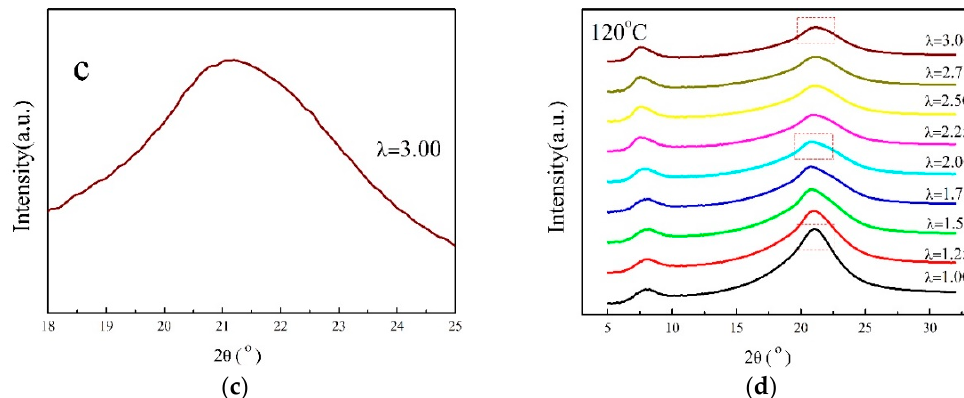
Figure 5. XRD patterns of γ -PA1010 stretched at 120 °C (( a – c ) are partial high magnification image of = 1.00, 2.00 and 3.00, respectively); ( d ) XRD patterns of different draw ratio.